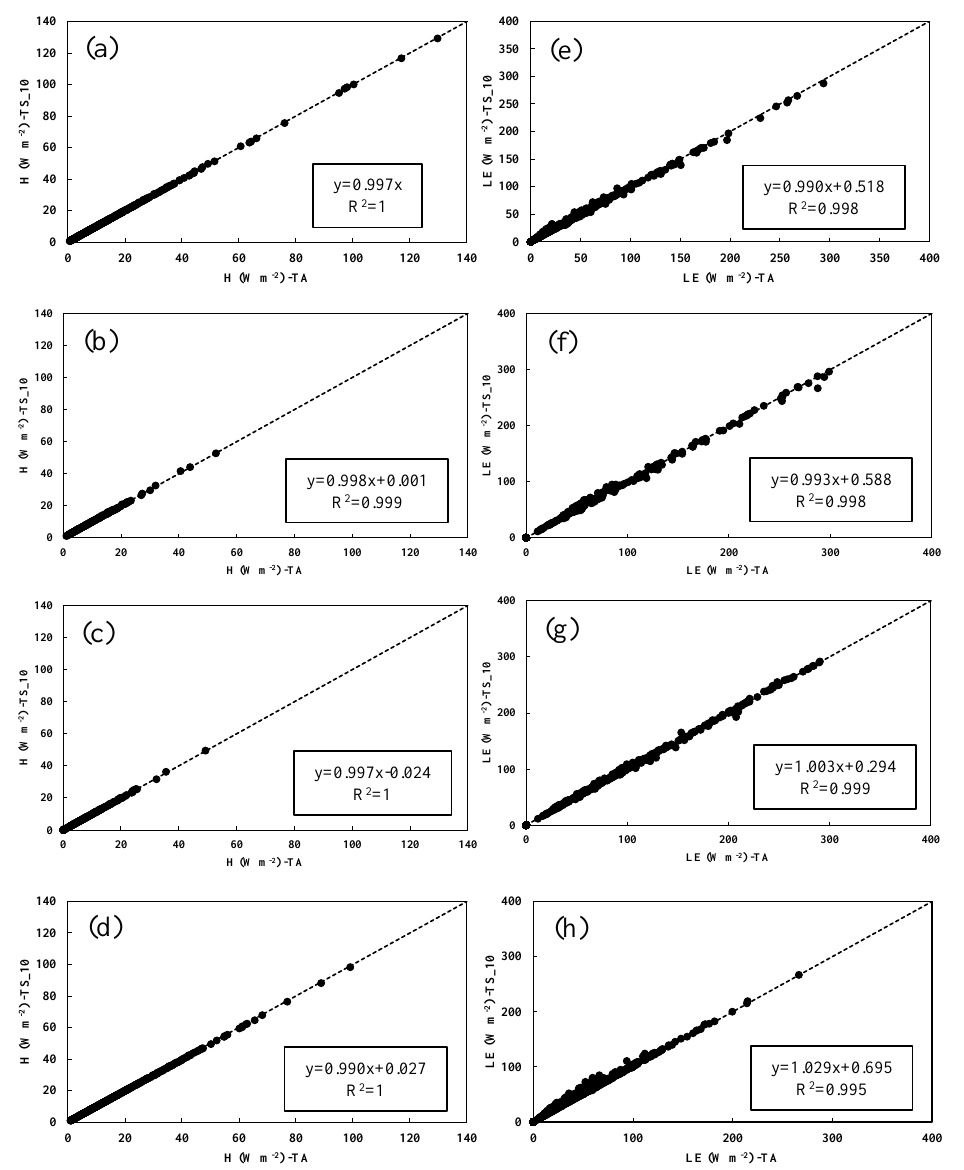
Figure 4. Comparison of the estimated results of H and LE between (cid:49) obtained from the polynomial equation at air temperature and (cid:49) calculated by the original formula at 10cm depth in January and February, 2013 (a, e) , May and June, 2013 (b, f) , July and August, 2014 (c, g) , and November and December, 2012 (d, h)